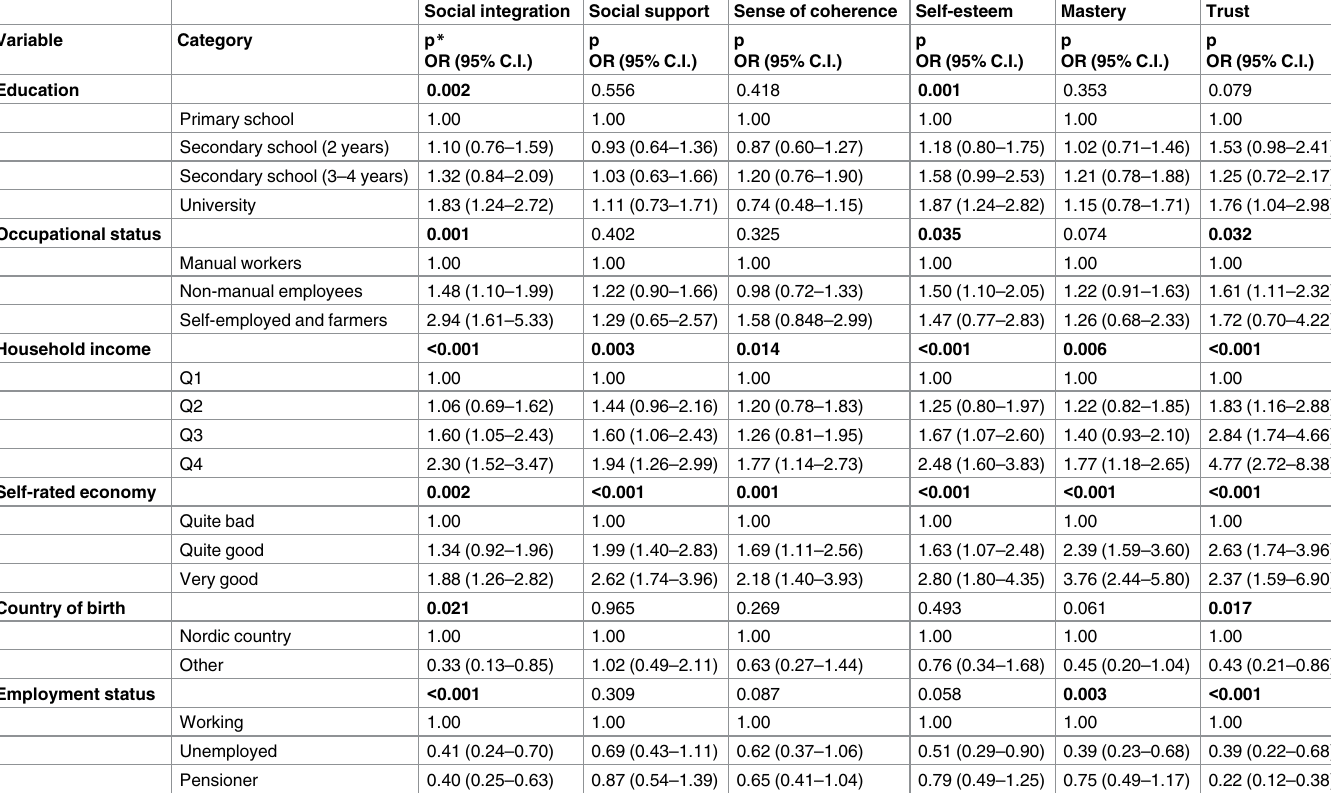
Table 4. Logistic regression models of socioeconomic status and psychosocial resources, adjusted for age and sex. Social integration Social support Sense of coherence